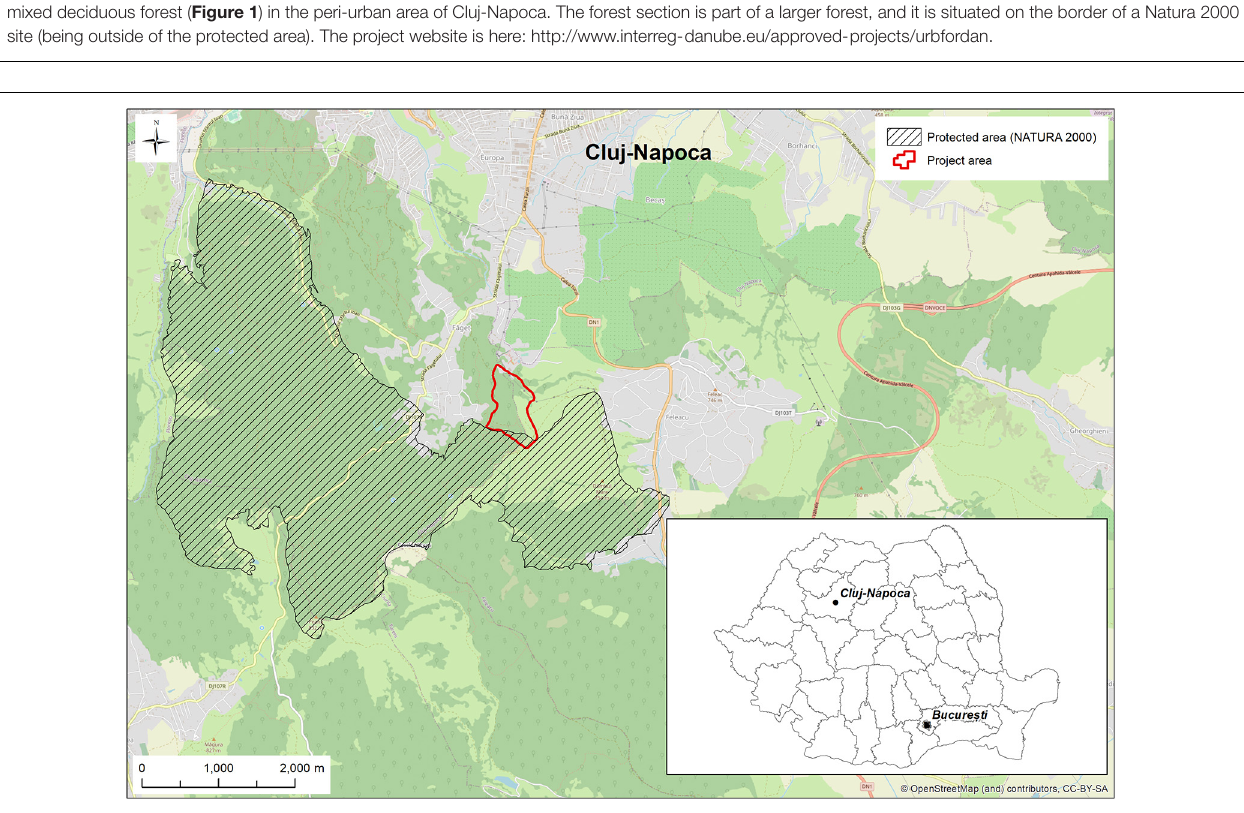
FIGURE 1 | The focal forest targeted by the project URBforDAN (outlined in